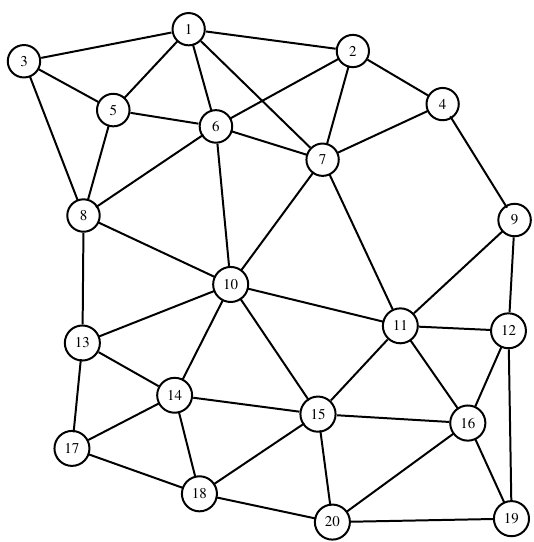
Fig. 3. Graphic representation of the underlying graph of